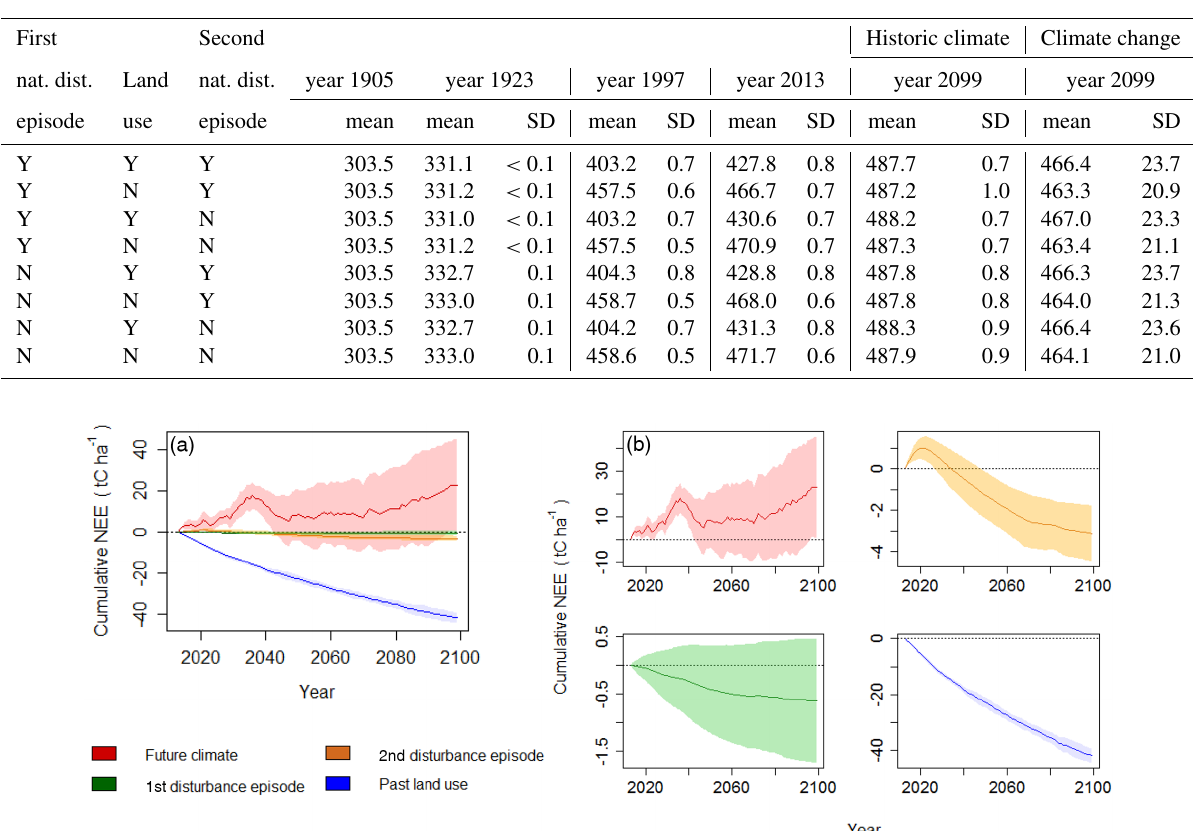
Table 1. Development of total ecosystem carbon stocks (tCha − 1 ) over time and in different scenarios of disturbance, land-use history, and future climate. Values are based on iLand simulations and indicate means and standard deviations (SD) over averaged landscape values of the replicates in the respective scenarios. “Historic climate” assumes the continuation of the climate 1950–2010 throughout the 21st century, while “Climate change” summarizes the effect of three alternative climate change scenarios for the 21st century. The first three columns indicate the respective permutation of the simulated disturbance and land-use history, with the first line representing the historical reconstruction of landscape development. Y = yes, N = no.